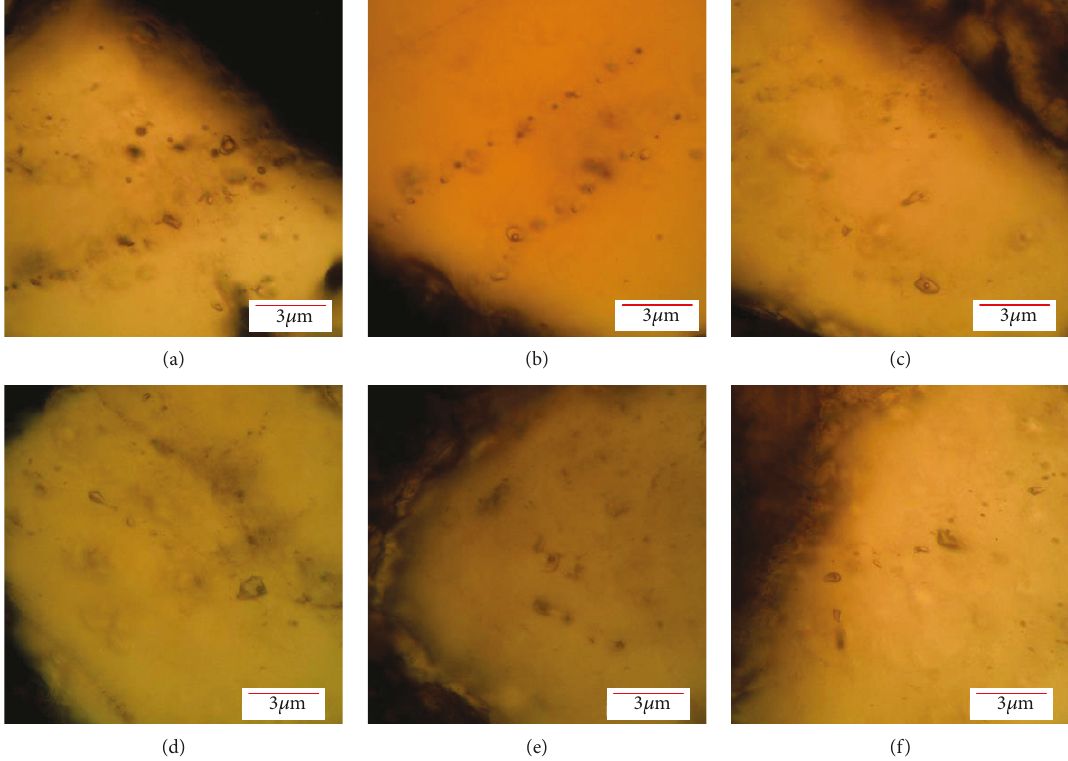
Figure 10: The production and morphological characteristics of fl uid inclusions in shale of the Upper Ordovician Xinkailing Formation and the Lower Cambrian Wangyinpu Formation in the Jiangye-1 Well, Xiuwu Basin. (a) Transmissive photo of elliptical methane inclusions in the quartz minerals of secondary enlargement, Jiangye-1 Well, 1343.26m depth, the Upper Ordovician Xinkailing Formation. (b) Transmissive photo of methane inclusions of irregular forms in the quartz minerals of secondary enlargement, Jiangye-1 Well, 1349.01m depth, the Upper Ordovician Xinkailing Formation. (c) Transmissive photo of brine inclusions of irregular forms in the quartz minerals of secondary enlargement, Jiangye-1 Well, 1351.61 m depth, the Upper Ordovician Xinkailing Formation. (d) Transmissive photo of methane inclusions of irregular forms in the quartz minerals of secondary enlargement, Jiangye-1 Well, 2621.40m depth, the Lower Cambrian Wangyinpu Formation. (e) Transmissive photo of brine inclusions of irregular forms in the quartz fractures, Jiangye-1 Well, 2621.40m depth, the Lower Cambrian Wangyinpu Formation. (f) Transmissive photo of brine inclusions of irregular forms in the quartz minerals of secondary enlargement, Jiangye-1 Well, 2635.25m depth, the Lower Cambrian Wangyinpu Formation. See Figure 1 for the well locations.